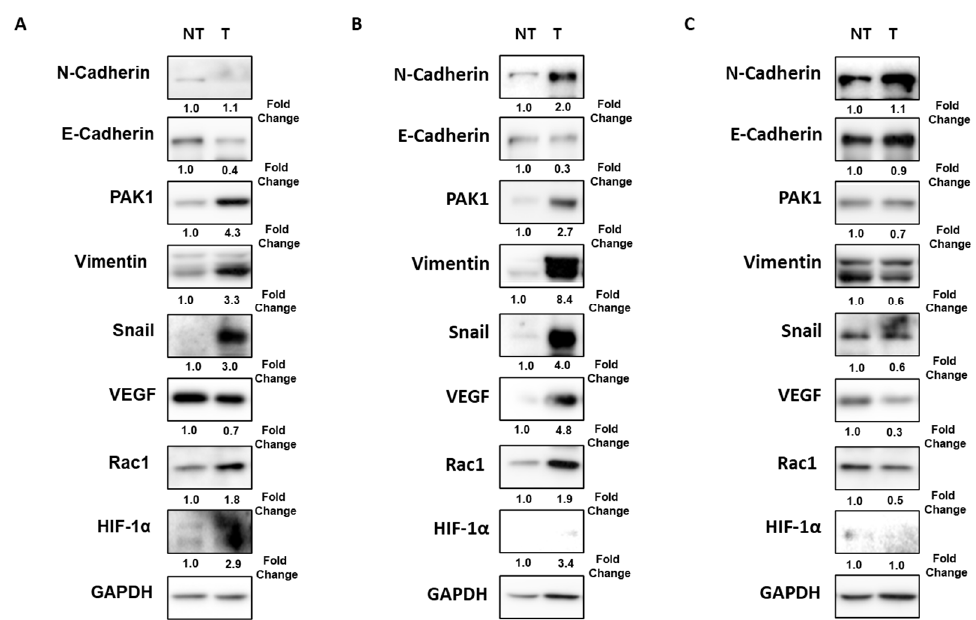
Figure 1. Combined EMT markers expression according to the tumor stage in patients with HCC. ( A ) Down-expression of E-cadherin and overexpression of PAK1/Snail in a 65-year-old man with 14 cm sized tumor and portal vein invasion (TNM stage IIIB). ( B ) Down-expression of E-cadherin and overexpression of PAK1/Snail in a 55-year-old man with 4 cm sized tumor and MVI (TNM stage II). ( C ) No combined EMT markers expression in a 71-year-old man with 3 cm sized tumor without vascular invasion (TNM stage IB). EMT, epithelial–mesenchymal transition; HCC, hepatocellular carcinoma; MVI, microvascular invasion; NT, non-tumor; T, tumor; PAK, p21-activated kinases; VEGF, vascular endothelial growth factor; HIF, hypoxia-inducible factor; GAPDH, glyceraldehyde 3-phosphate dehydrogenase. Table 3. Sensitivity and specificity of EMT markers for prediction of MVI in patients with